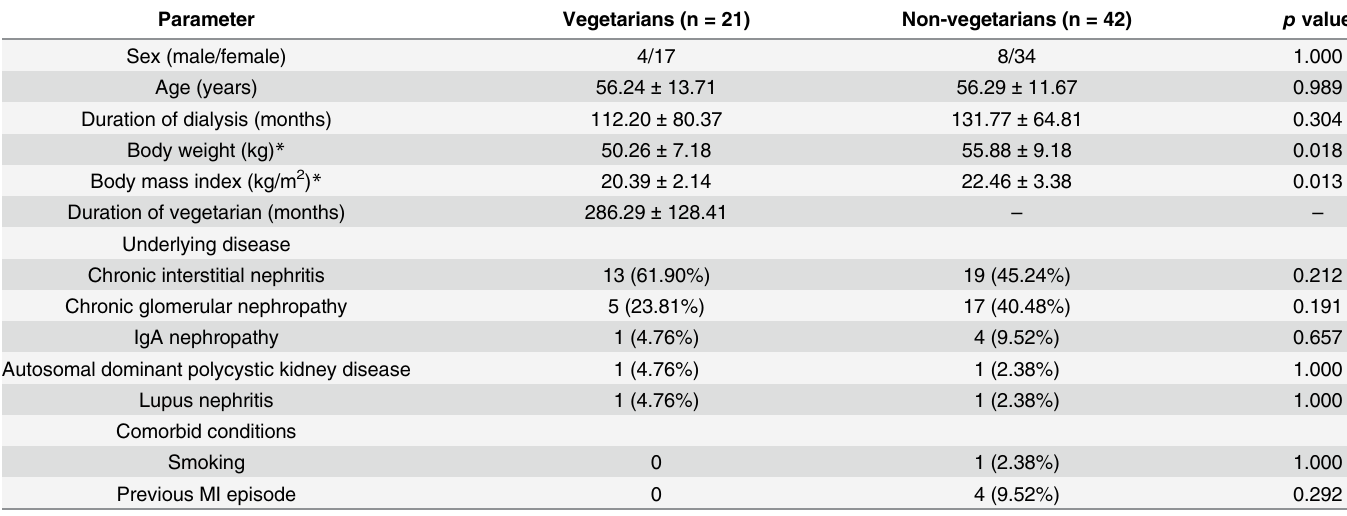
Table 1. Demographic differences between the vegetarian and non-vegetarian